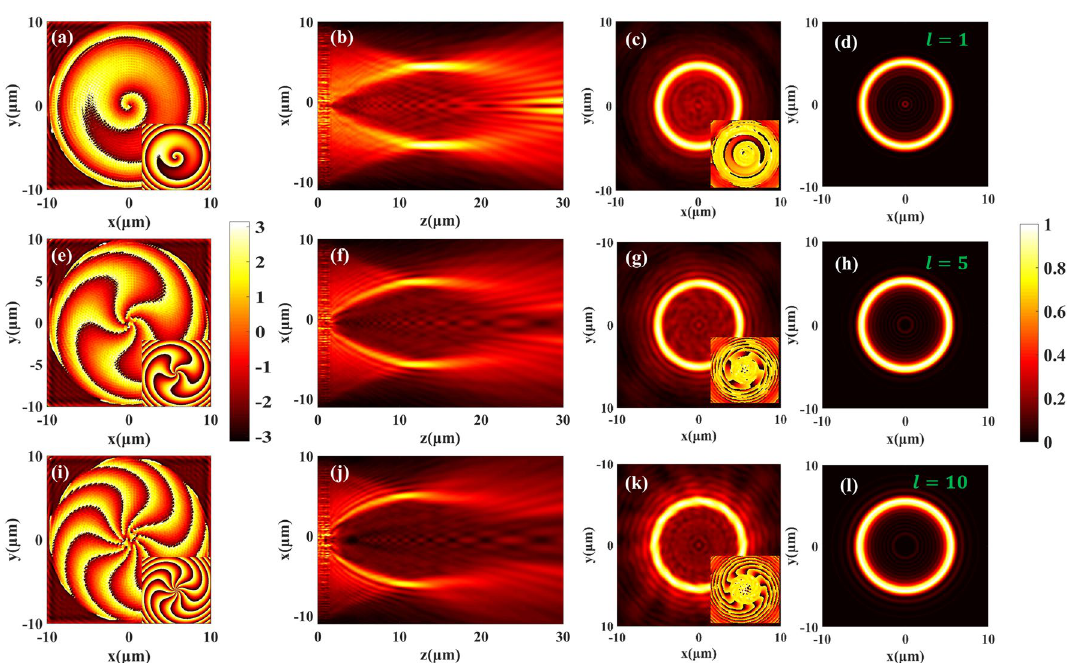
Figure 2. The phase and electric field distributions of Q-PVs. ( a , e , i ) The simulated phase distribution after the metasurface when l equals 1, 5, and 10, respectively. The insets show the designed phase distributions. ( b , f , j ) The longitudinal section of the Q-PV light field on the xOz plane; ( c , g , k ) The simulated electric field intensity distributions in the focal planes and the insets represent the corresponding phase distributions; ( d , h , l ) The theoretical light field calculated by Fresnel integration diffraction theory. All the simulated light field distributions were decreased at angles of 0 or 90 degrees, still remaining above 75%. The red line with dots shows the phase delay of the TiO